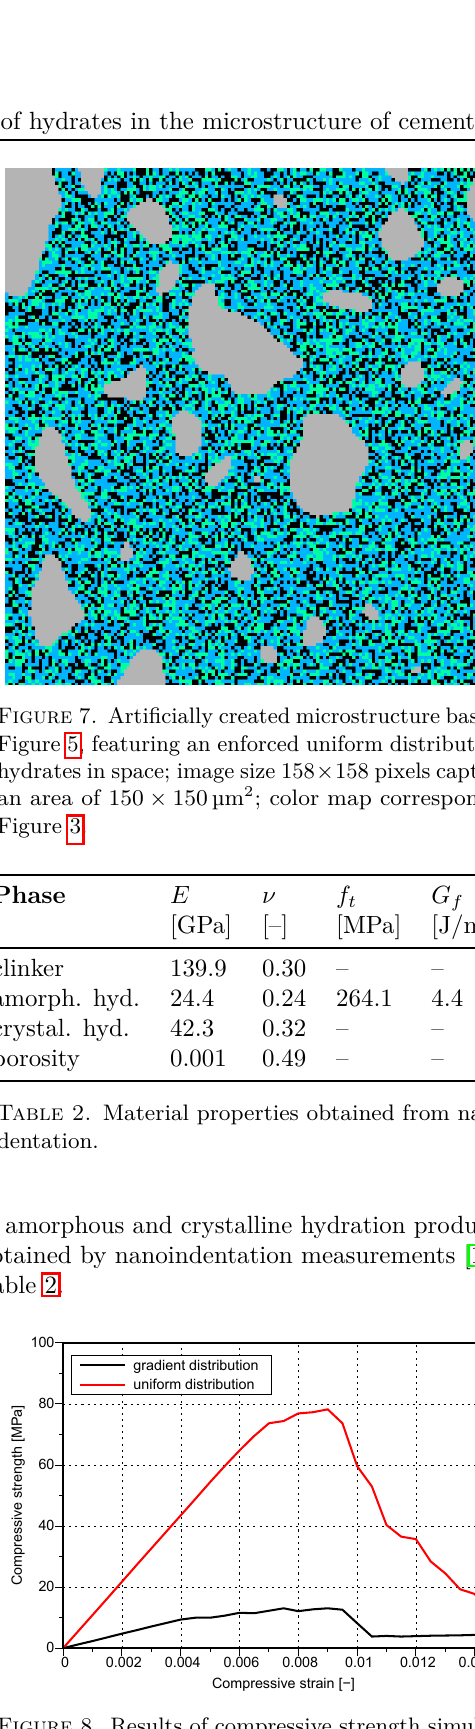
Figure 8. Results of compressive strength simulation for both hydrate spatial distributions (gradient and uniform) for virtual microstructures of cement ID 133 at 124